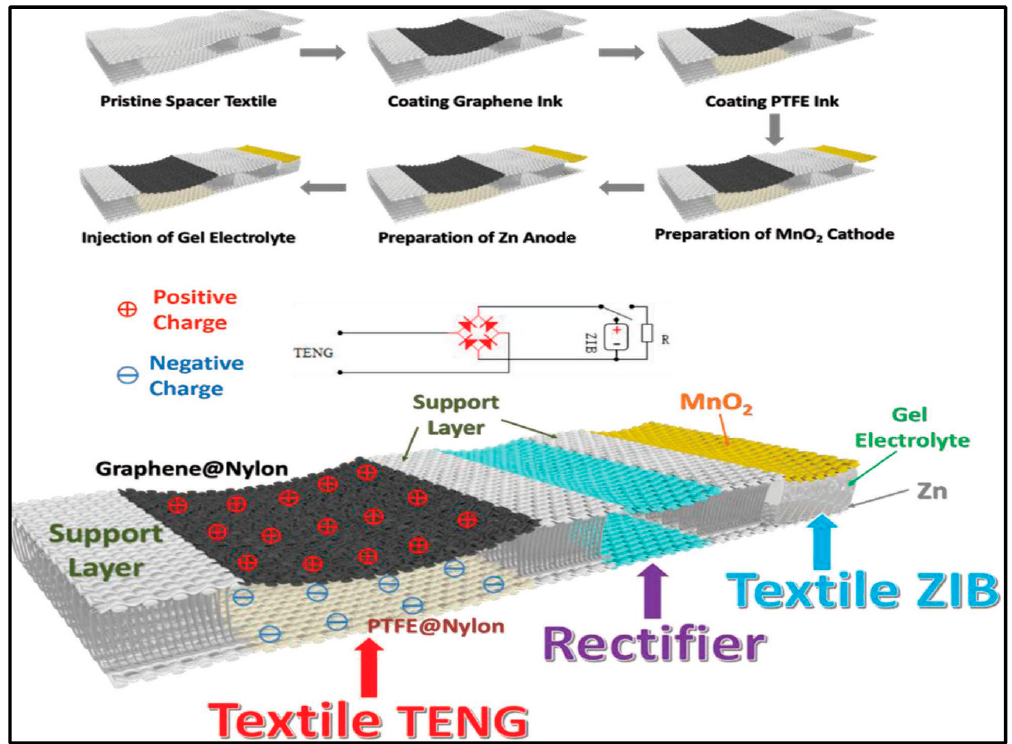
Figure 20. Fabrication protocol and the schematic diagram of the 3D spacer fabric-based energy harvesting and storage device. Reproduced with permission from [318]. Copyright 2018 Wiley.